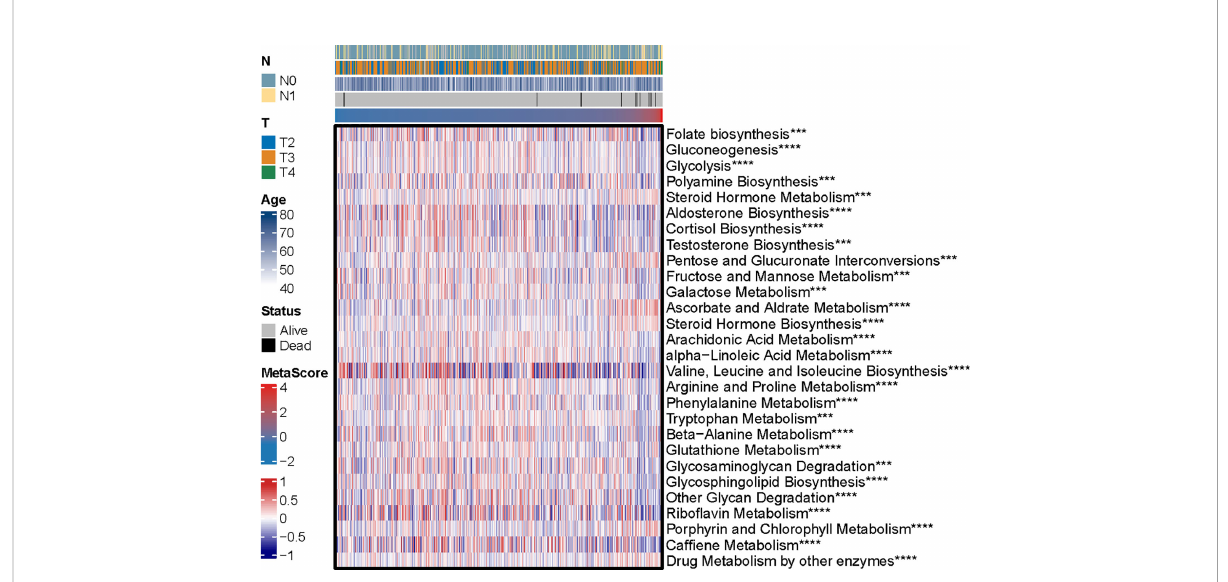
FIGURE 4 The heatmap was employed to visualize the most signi fi cant pathways among 114 identi fi ed metabolic-related pathways correlation to MetaScore. ***p < 0.001, ****P <